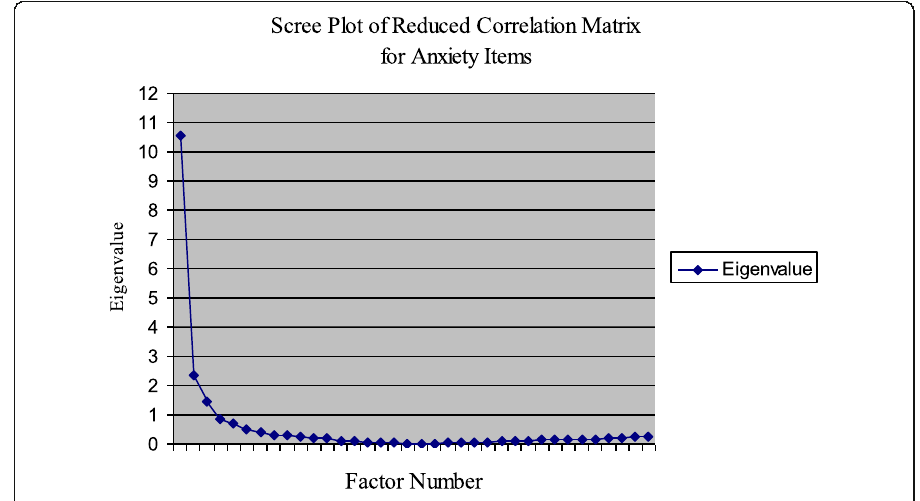
Fig. 1 Scree plot for anxiety